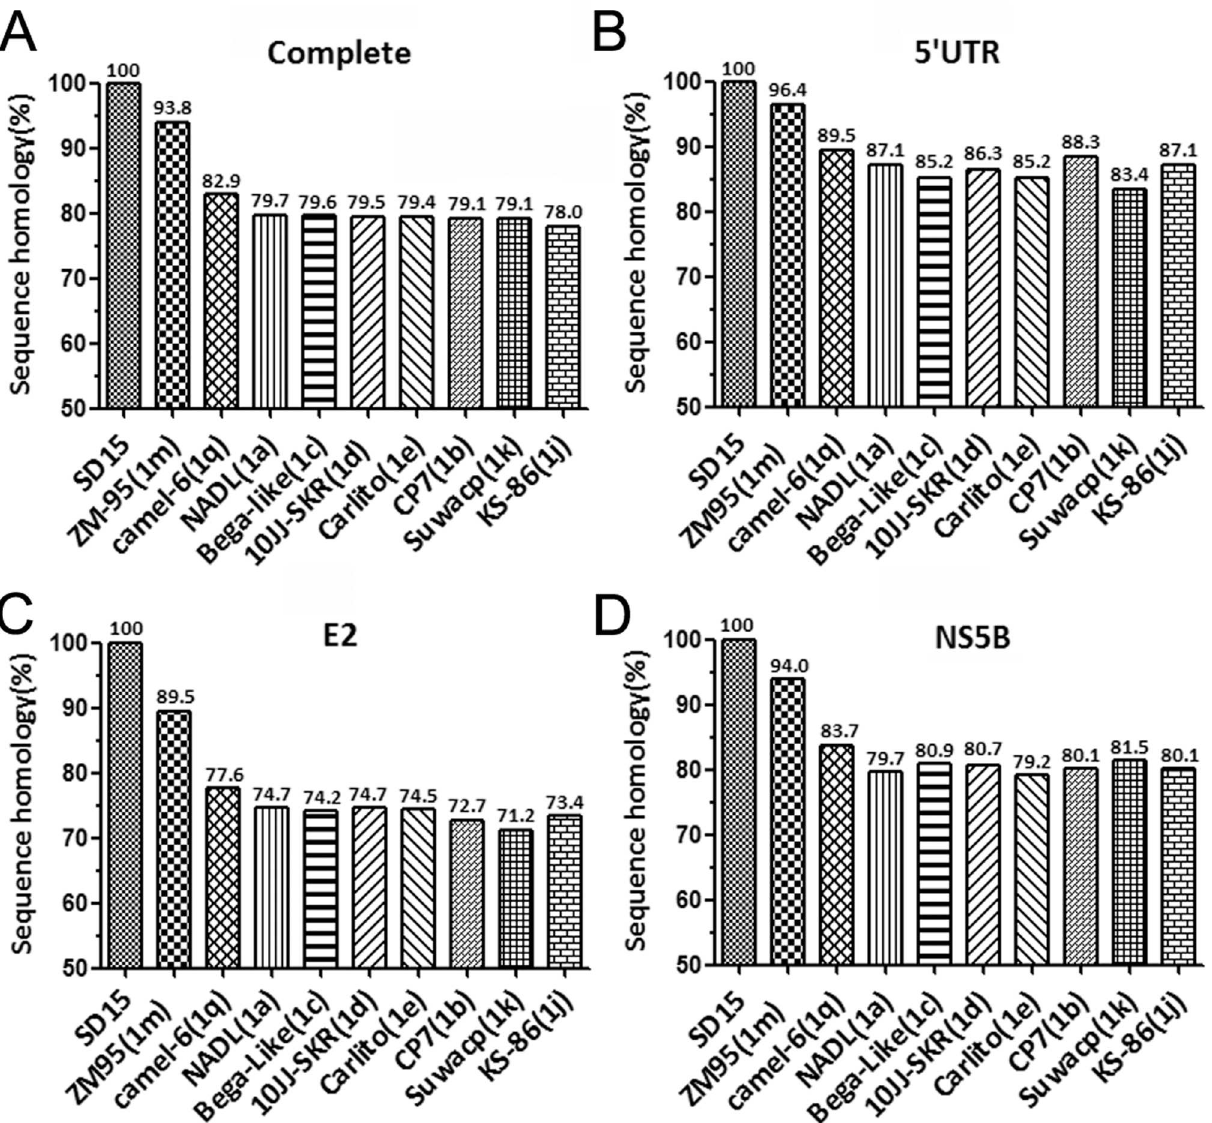
Fig 4. SD-15 is evolutionarily closed to ZM-95 and had diversified sequence homology with other BVDV-1 subgenotypes. The complete genome(A), 5’-UTR (B), E2 (C) and NS5B (D) nucleotide sequencesof SD-15 were alignedwith different BVDV-1 subgenotypes by the DNASTAR software. Sequence identitiesof SD-15 genes with other BVDV-1 subgenotypes were shown beyondthe bars,